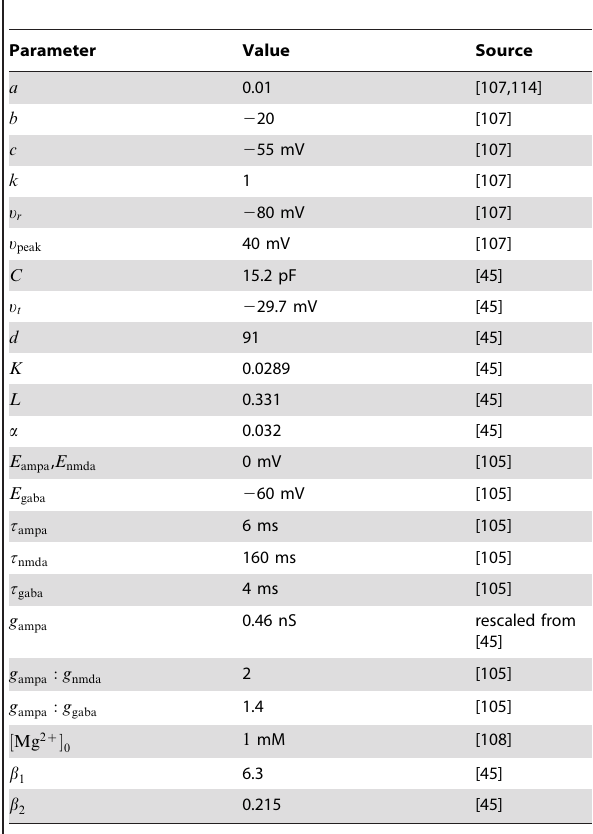
Table 2. Intrinsic and synaptic parameters for the medium spiny neuron